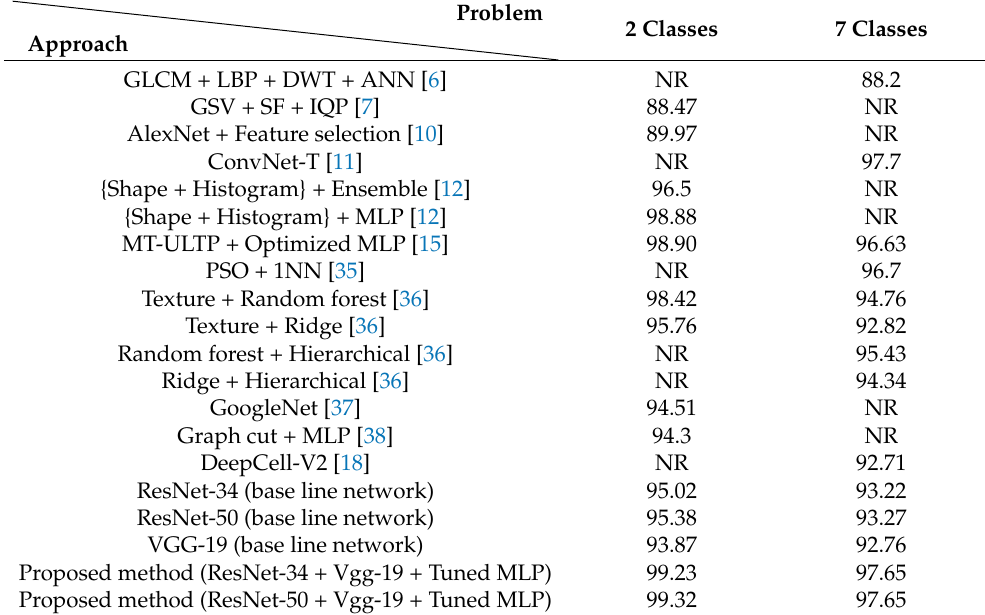
Table 6. Comparison results on the Herlev dataset in terms of accuracy